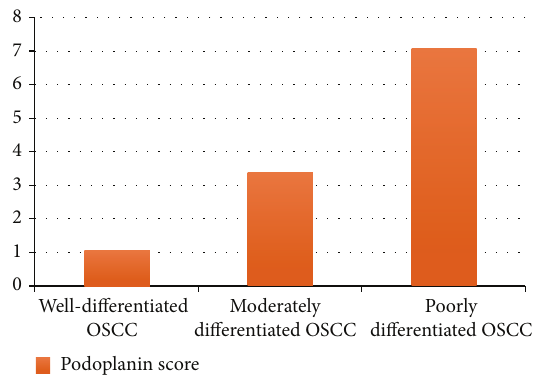
Figure 2: Graph showing increasing expression of podoplanin in OSCC as the grade of carcinoma